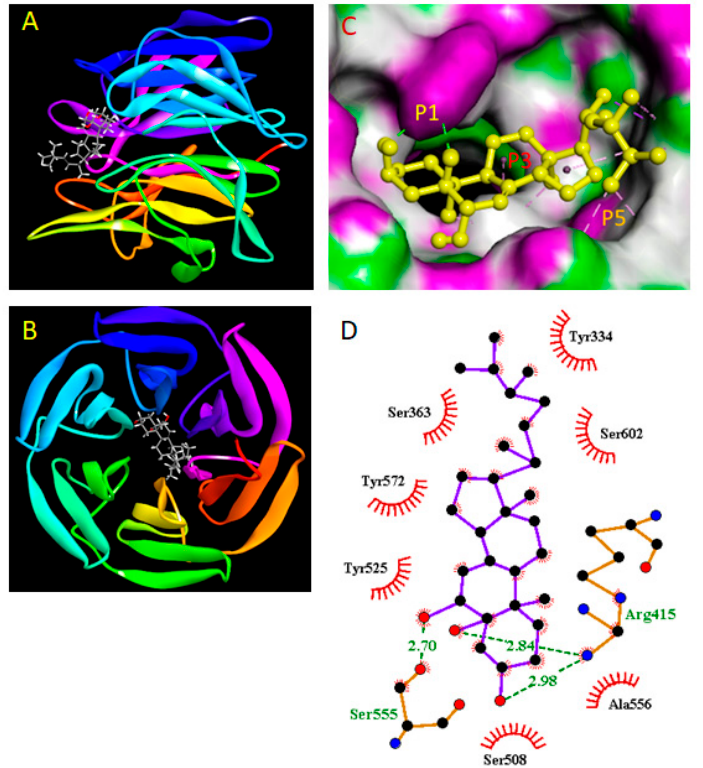
Figure 5. Analysis of the molecular docking between CRVS and Keap-1. Front view ( A ) and top view ( B ) of the docking mode of CRVS (azure and red) in the binding site of Keap1 (shown in ribbon representation). The binding mode of CRVS with Keap-1 in the co-crystallization form (PDB code 4L7B) ( C ). 2D binding interaction between CRVS and Keap-1 was generated by LigPlot. The green line represents the hydrogen bond interactions ( D ).